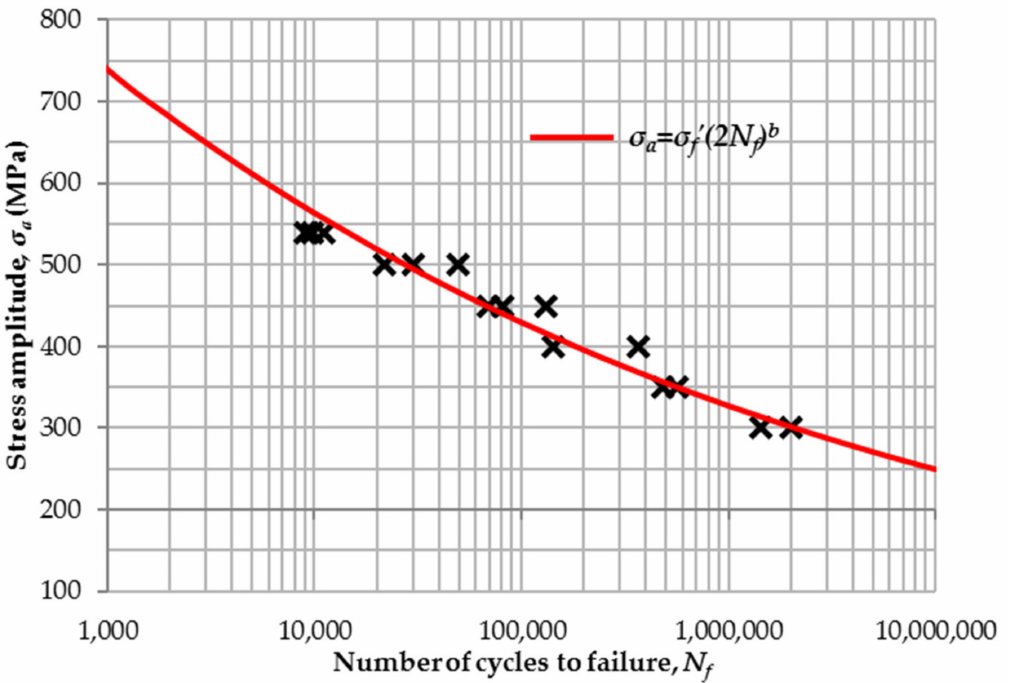
Figure 7. Semi-log S – N curve for uniaxial stress-controlled tests of S690QL steel grade.